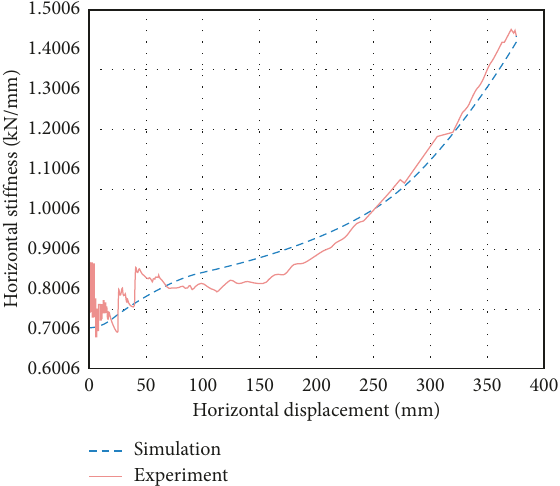
Figure 32: Comparison of horizontal stiffness-horizontal dis- placement relationship curve.